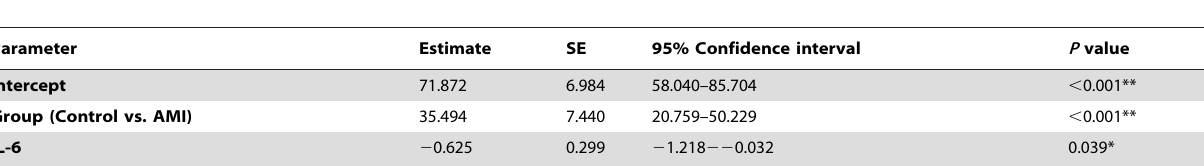
Parameter Estimate SE 95% Confidence interval P value Intercept 71.872 6.984 58.040–85.704 , 0.001** Group (Control vs. AMI) 35.494 20.759–50.229 , 0.001** IL-6 2 0.625 0.299 2 1.218 22 0.032